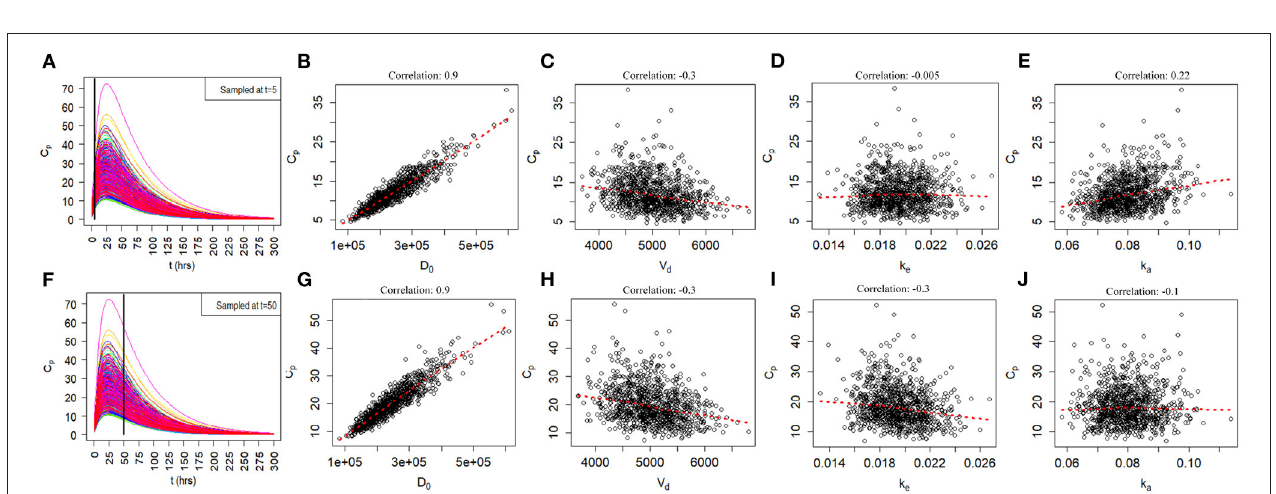
FIGURE 5 | PCC of the model output with the input parameters k e and k a and the model inputs V d and D 0 plotted over time. (A) Correlations for GFAP model. (B) Correlations for NF-L model. Partial correlations near +1.0 and − 1.0 show strong correlations between input and output. Partial correlations near 0.0 show weak correlations. Note that D 0 correlates positively with C p at all times, and that V d correlates negatively with C p at all times. Partial correlations with k e and k a depend on time of measurement.